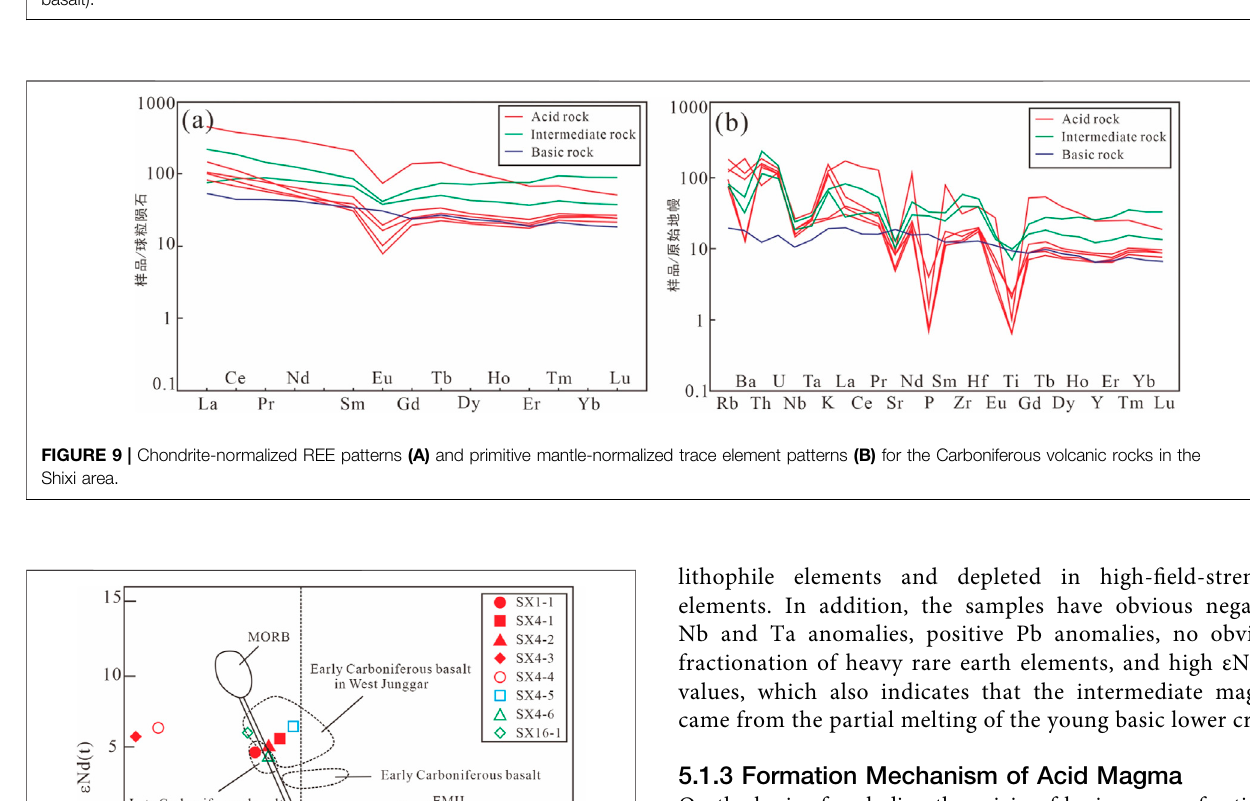
Frontiers in Earth Science |